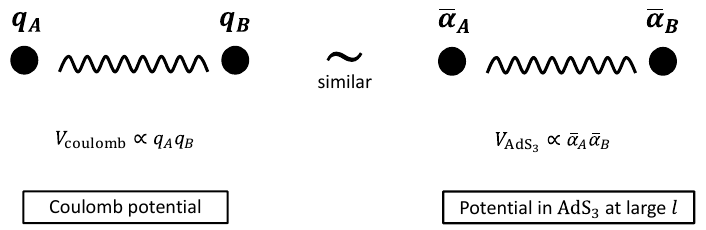
Figure 3 . Potential form in AdS 3 between two particles is similar to the form of Coulomb potential. Moreover, this form with Liouville momenta implies that the dynamics of the multiple de(cid:12)cit angle at large angular momentum is completely captured by Liouville